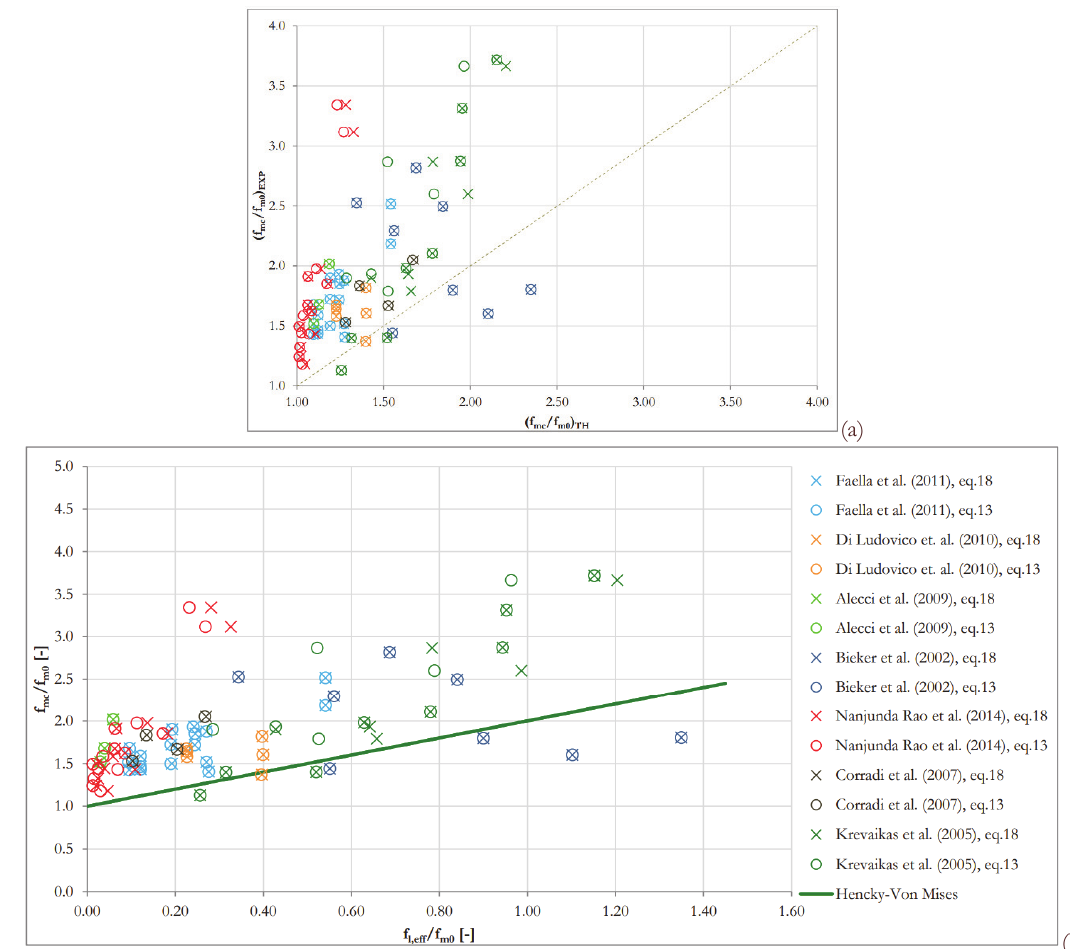
Figure 7: Comparison between experimental results and Hencky-Von Mises models: a) experimental and theoretical results comparison, b) confinement curve comparison independent on α